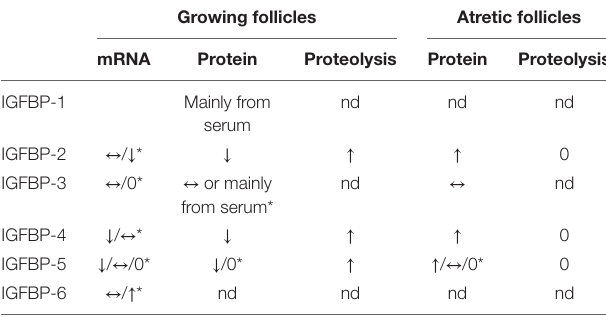
TABLe 1 | General overview of IGFBP contents variations during follicular growth and atresia in mammalian